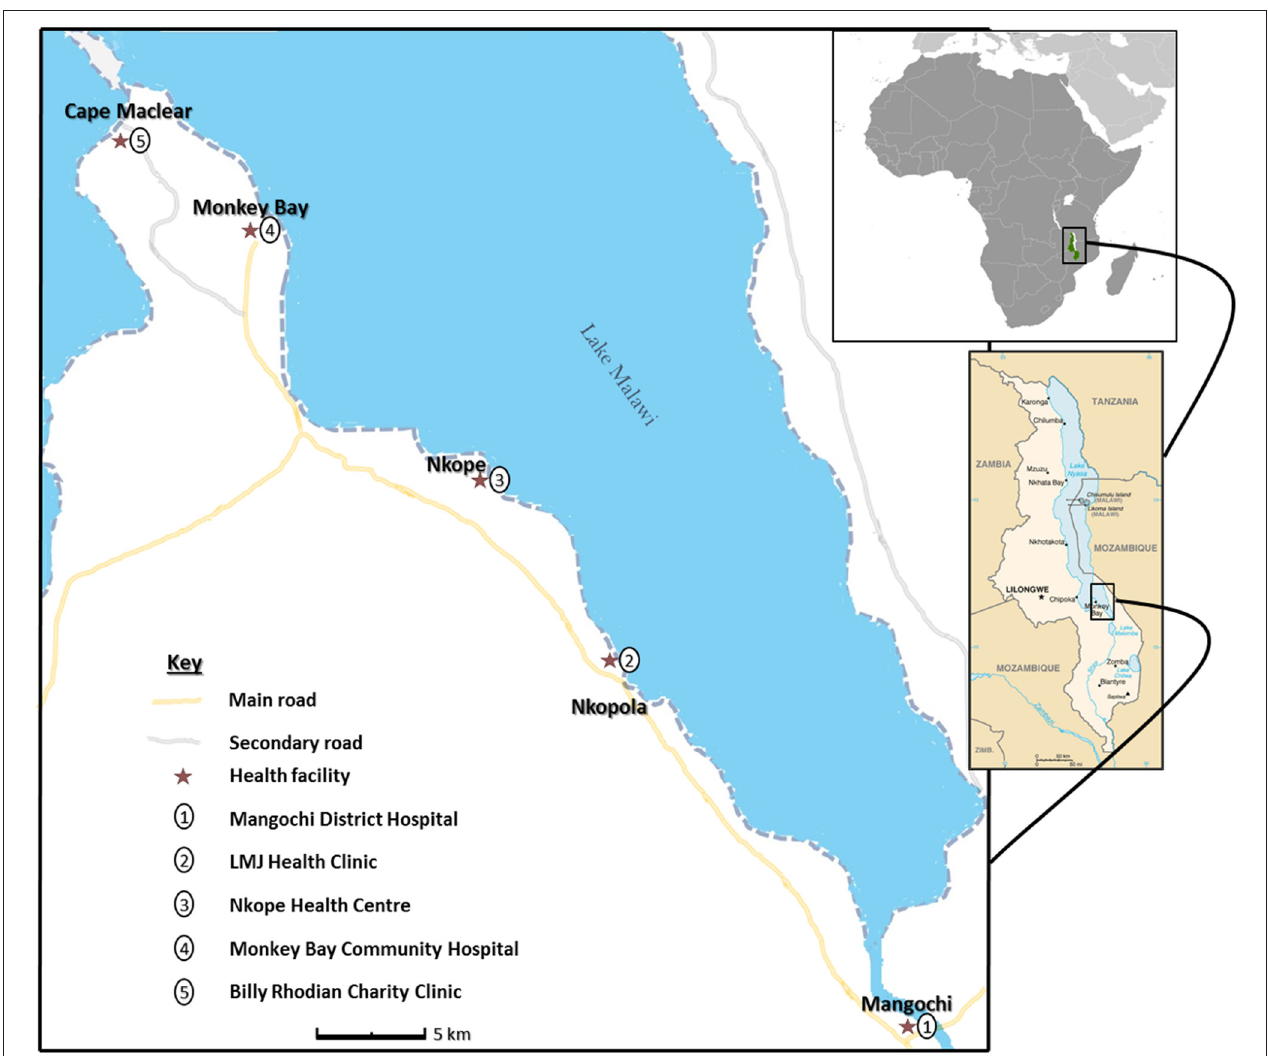
FIGURE 1 | Schematic map of study area showing health facilities along Lake Malawi. (The study map was produced by Dr. Sekeleghe Kayuni (4th August 2019), while the maps of Africa and Malawi were reproduced from the maps at the Central Intelligence Agency (CIA) website, public domain: https://www.cia.gov/library/ publications/the-world-factbook/attachments/locator-maps/MI-locator-map.gif and https://www.cia.gov/library/publications/the-world-factbook/attachments/maps/